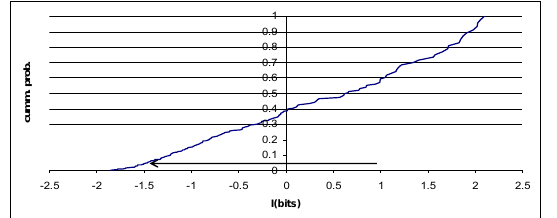
Figure 4. Mutual information cumulative distribution for one pixel – the arrow indicates the 0.05 threshold (95% confidence)